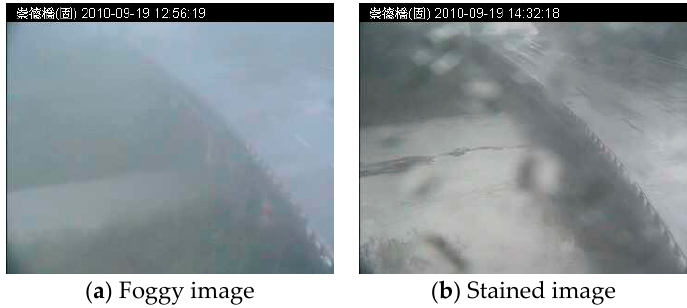
Figure 5. Image set and weather conditions. The image set was captured in adverse weather conditions. The selected sample images show fog ( a ) and stained ( b ) patterns. (Note: The Traditional Chinese in header of all images is represented the location in the Changed Bridge except).